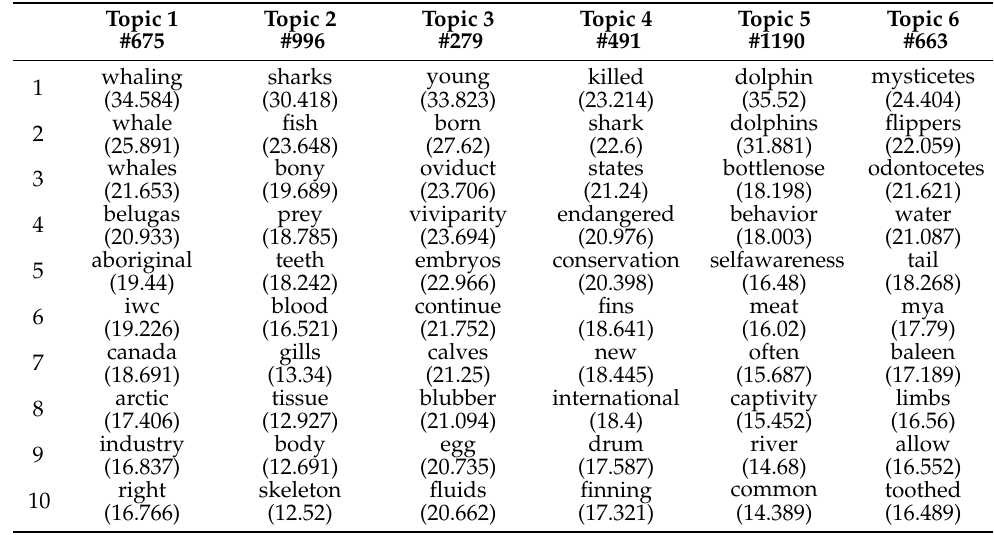
Table A12. Each column lists the top 10 representative words per dimension of the basis matrix H .